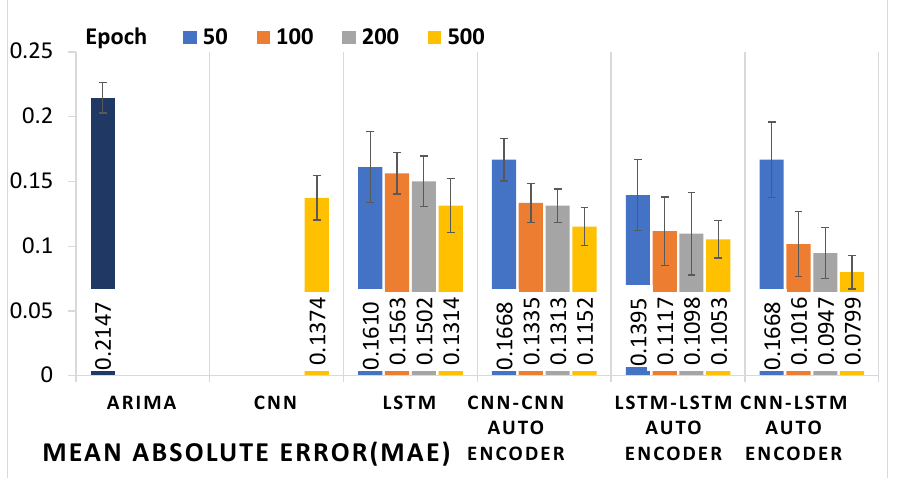
Figure 7. MAE of different forecasting